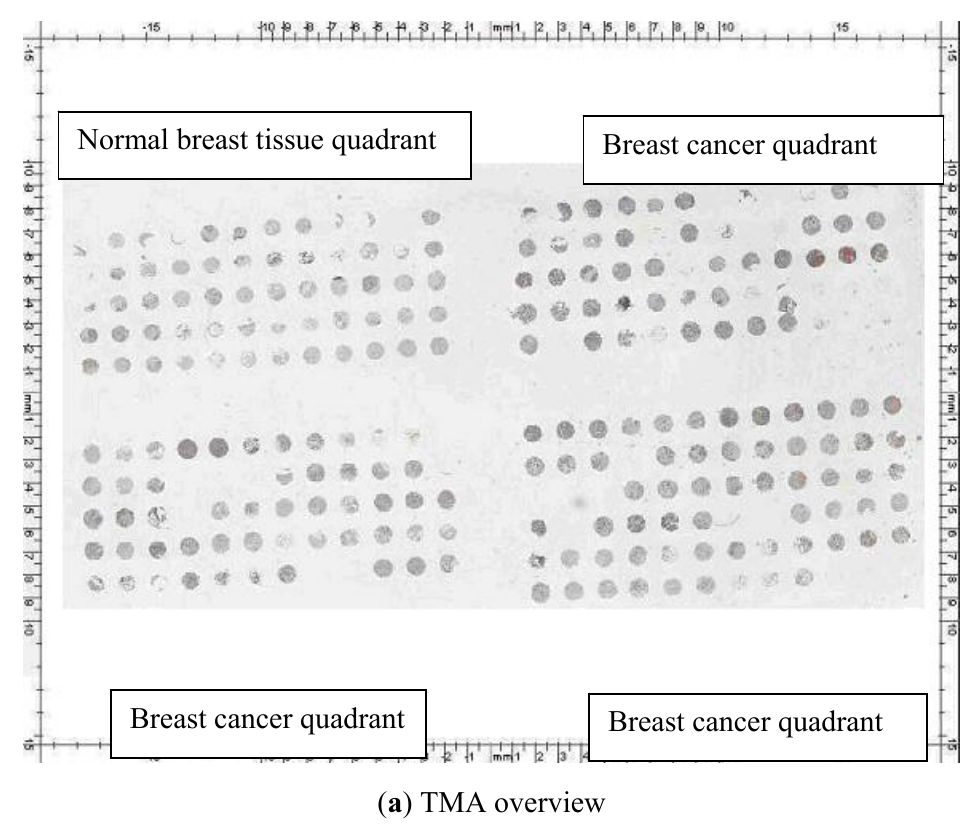
Figure 1. CENPA immunostaining (1:200 dilution). ( a ) Snapshot of the tissue microarray. The normal breast tissues with 20 cases (3 cores per case) are labeled in the first quadrant on the top left corner. The other 3 quadrants contain cancer samples (n = 63). ( b ) Low power (8.8X) view of normal breast tissue TMA core stained with CENPA. ( c ) Low power (8.8X) view of breast cancer TMA core stained with CENPA. ( d ) High power ( 40X) view of breast cancer TMA core stained with antibody to CENPA. The staining pattern